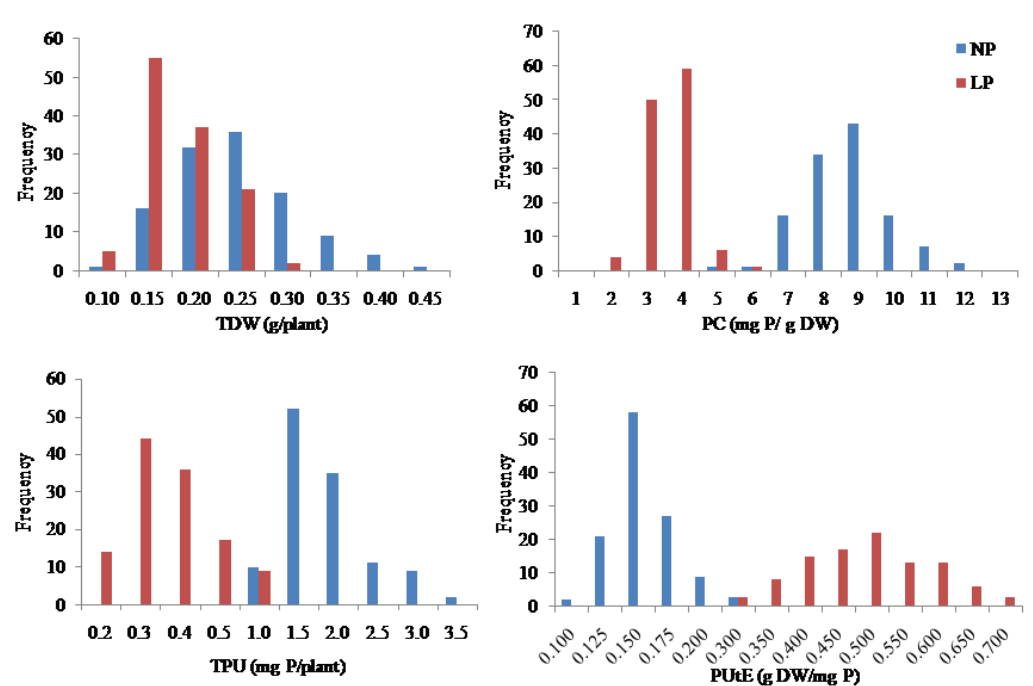
Figure 1. Frequency distribution of variation for total dry weight (TDW), P concentration (PC), total P uptake (TPU) and P utilization efficiency (PUtE) in 120 diverse mungbean genotypes under normal P (NP) and low P (LP) conditions. P, phosphorus; DW, dry weight.